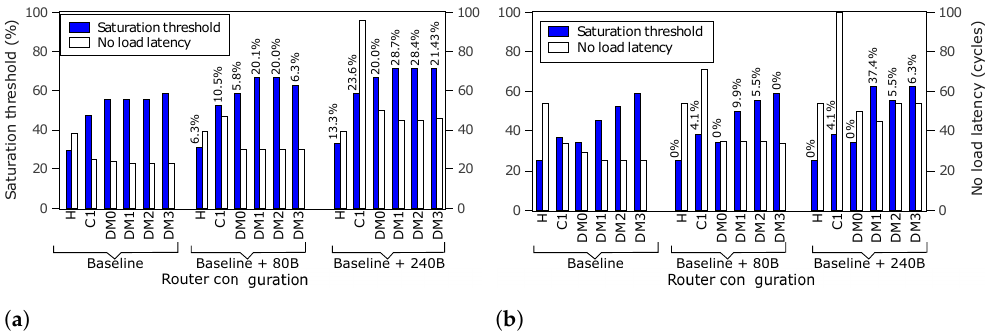
Figure 23. Performance for R-NoC-D and Hermes. Numbers on bars denote % increase in saturation threshold compared to baseline. ( a ) Performance for uniform traffic pattern. ( b ) Performance for transpose traffic